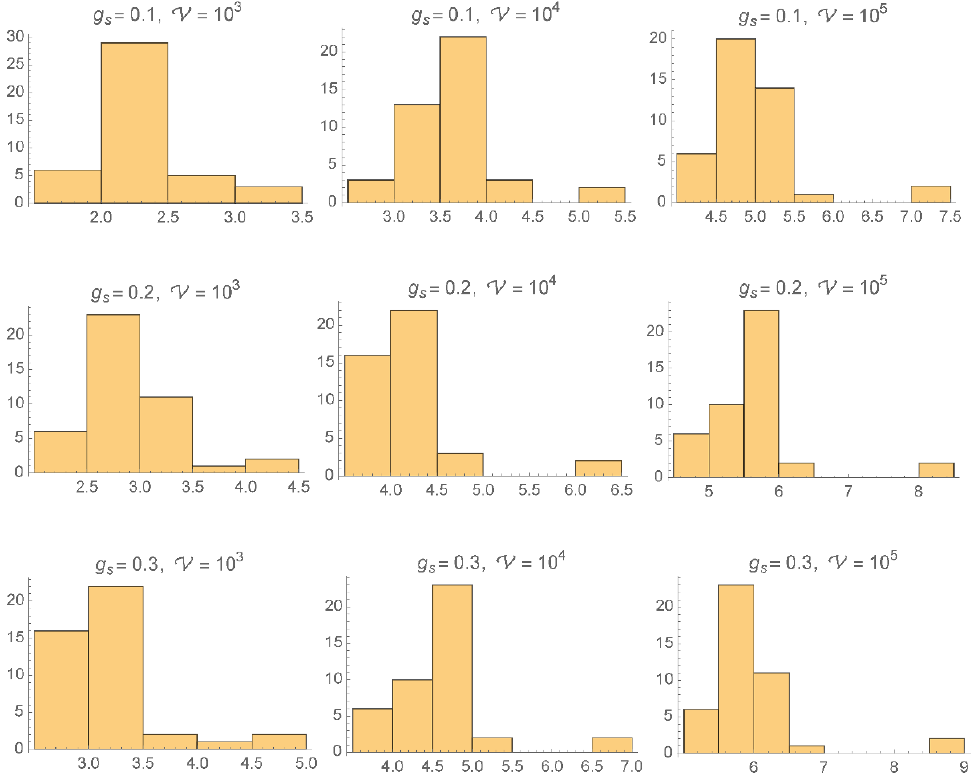
Figure 3 . Distribution of volumes in units of M p of the reduced moduli space M A;r for all 43 K3 (cid:12)bred LVS vacua for g s = 0 : 1, 0 : 2 and 0 : 3, and V